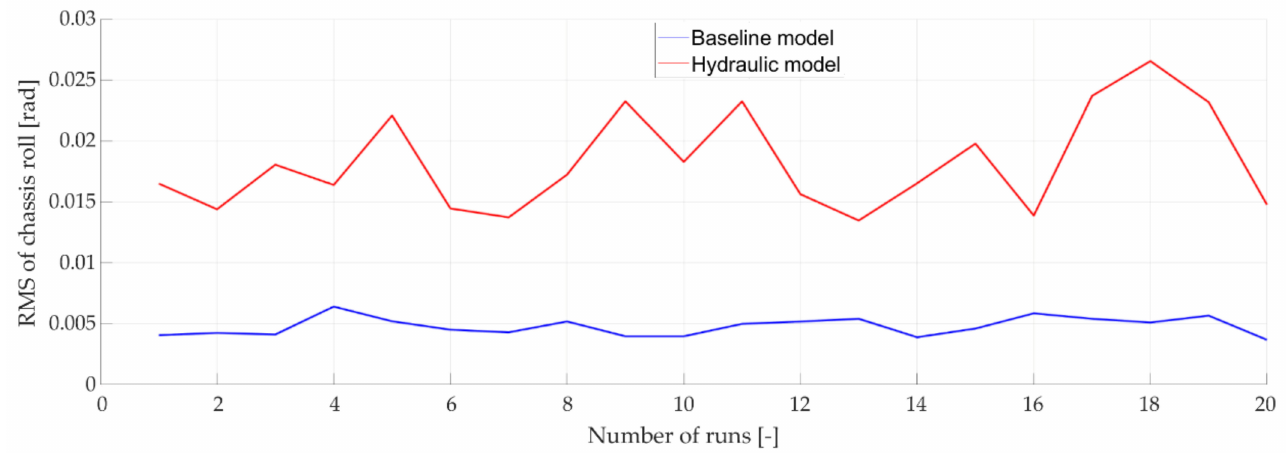
Figure 28. Chassis roll root means square for a realistic road profile and external